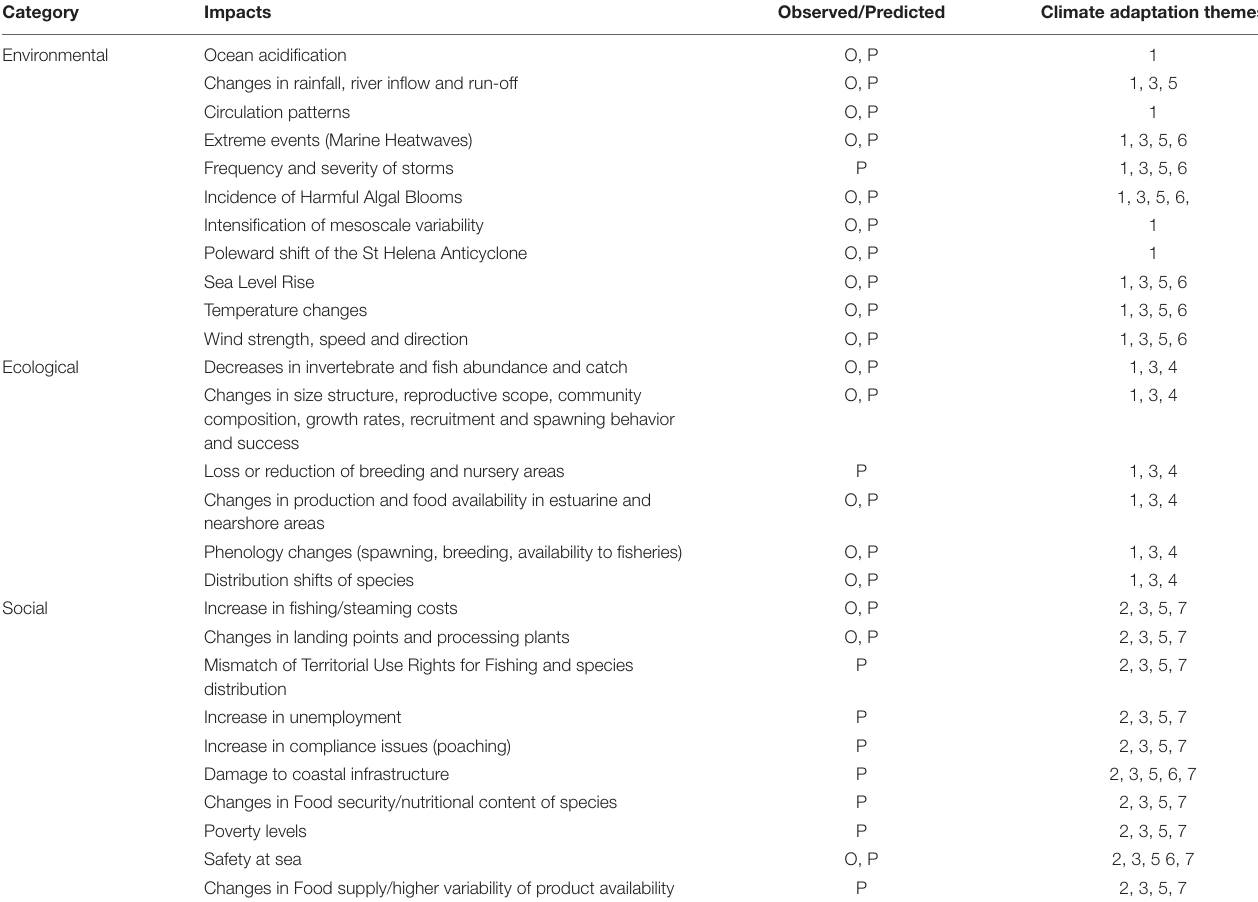
TABLE 1 | Observed and predicted climate change impacts in South Africa associated to the nine pre-determined climate adaptation